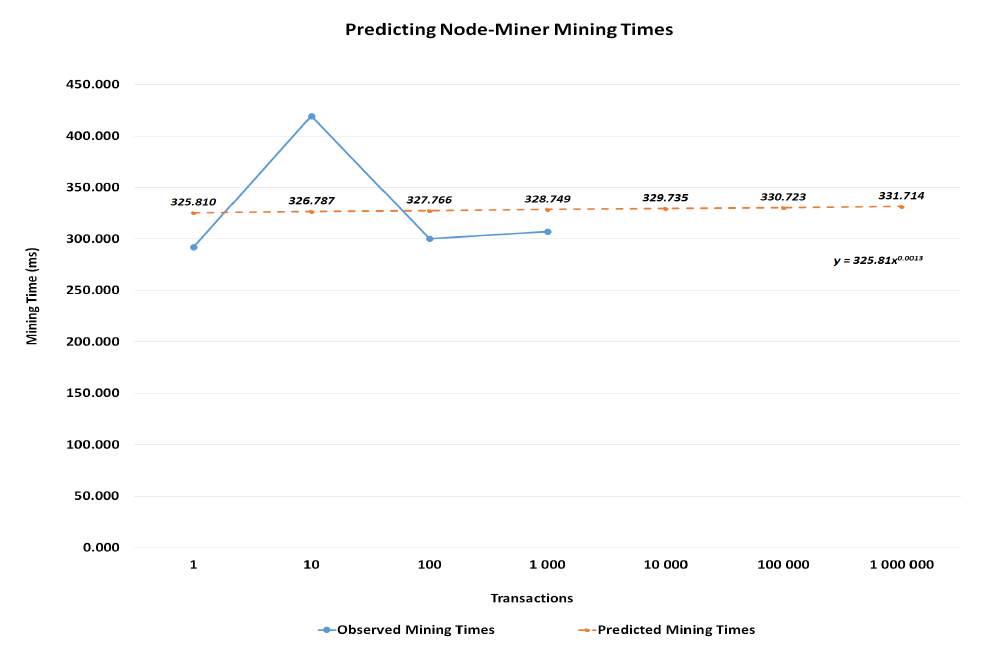
Figure 9. Mining time estimations for single node-miner